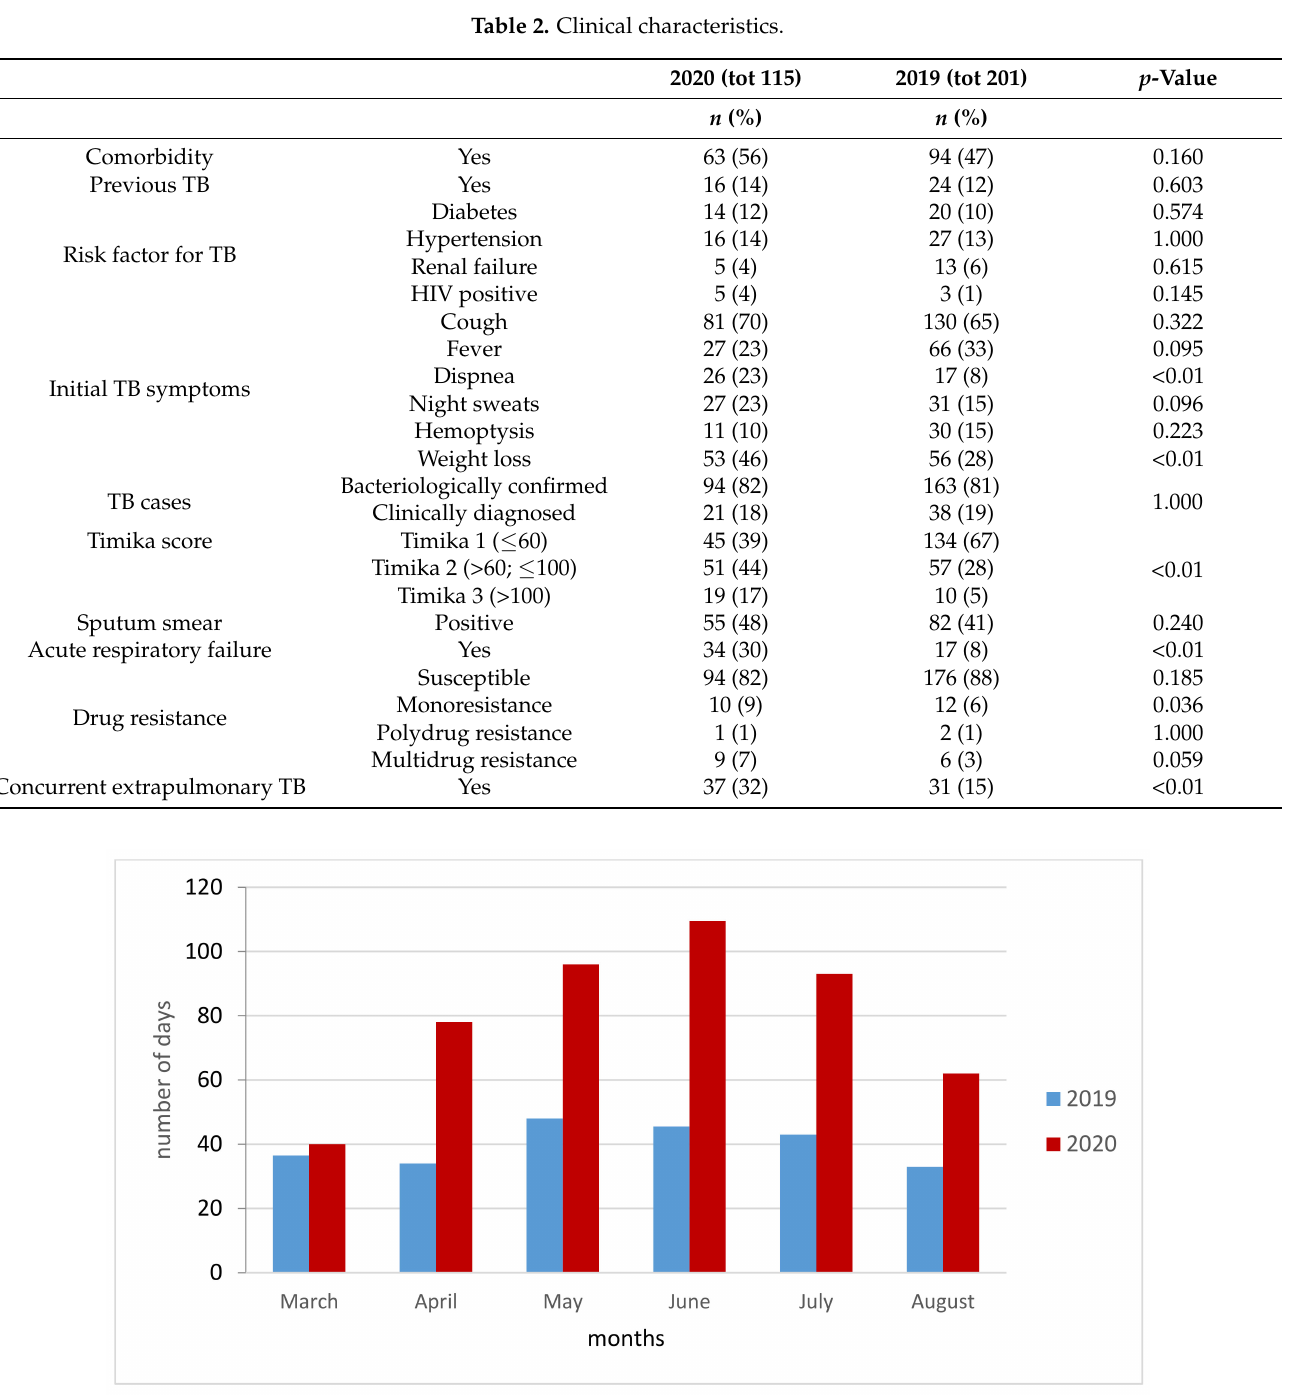
Figure 2. Monthly comparison of Total delay 2019 vs. 2020. Table 3. Diagnostic